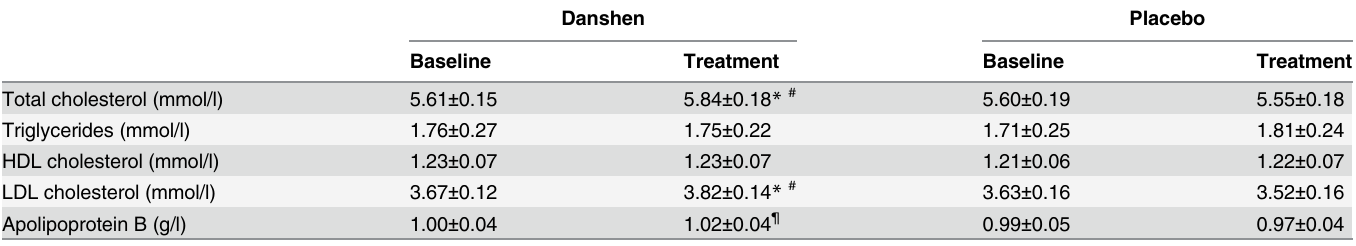
Table 2. Lipid levels before and after treatment with danshen and placebo. Results are provided as mean ± SEM. Baseline values did not significantly dif- fer between Danshen and placebo treatment.